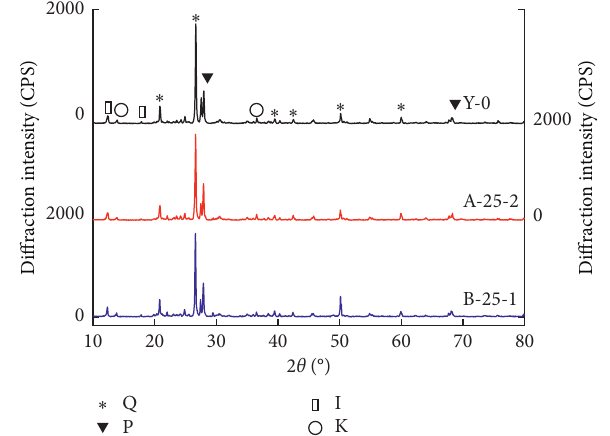
Figure 11: X-ray diffraction of the feldspar sandstones before and after the dry-wet cycles.